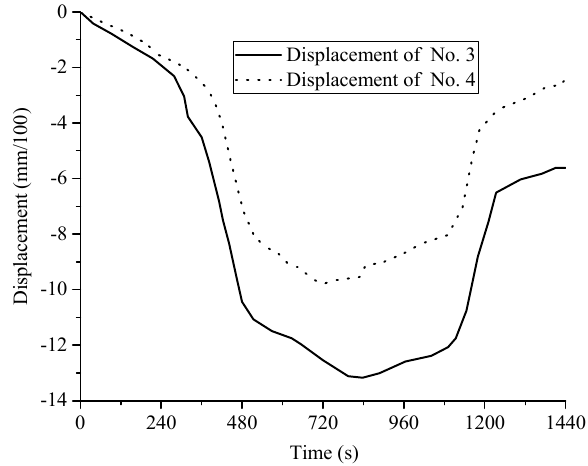
Figure 11. The relationship between displacement and time for No. 3 and No. 4 displacement meters, under the condition of first-down and then-up crossing.